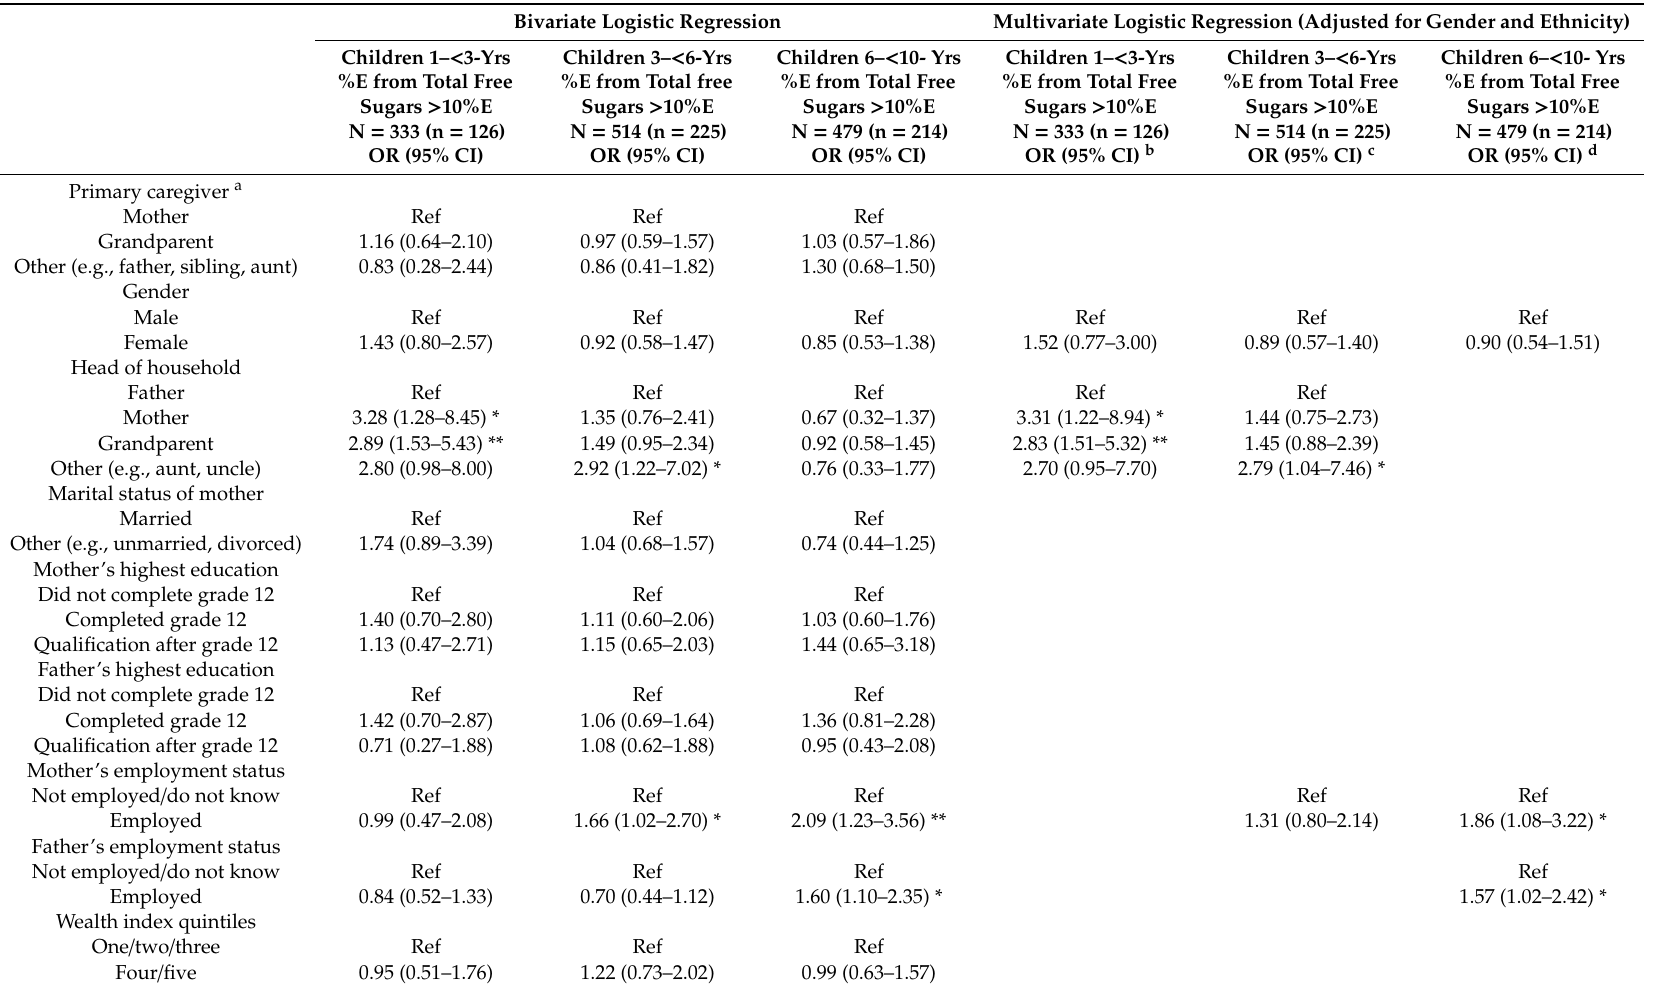
Table 10. Bivariate and multivariate logistic regression of sociodemographic factors on having a free sugars intake above the recommended 10%E by age group. Bivariate Logistic Regression Multivariate Logistic Regression (Adjusted for Gender and